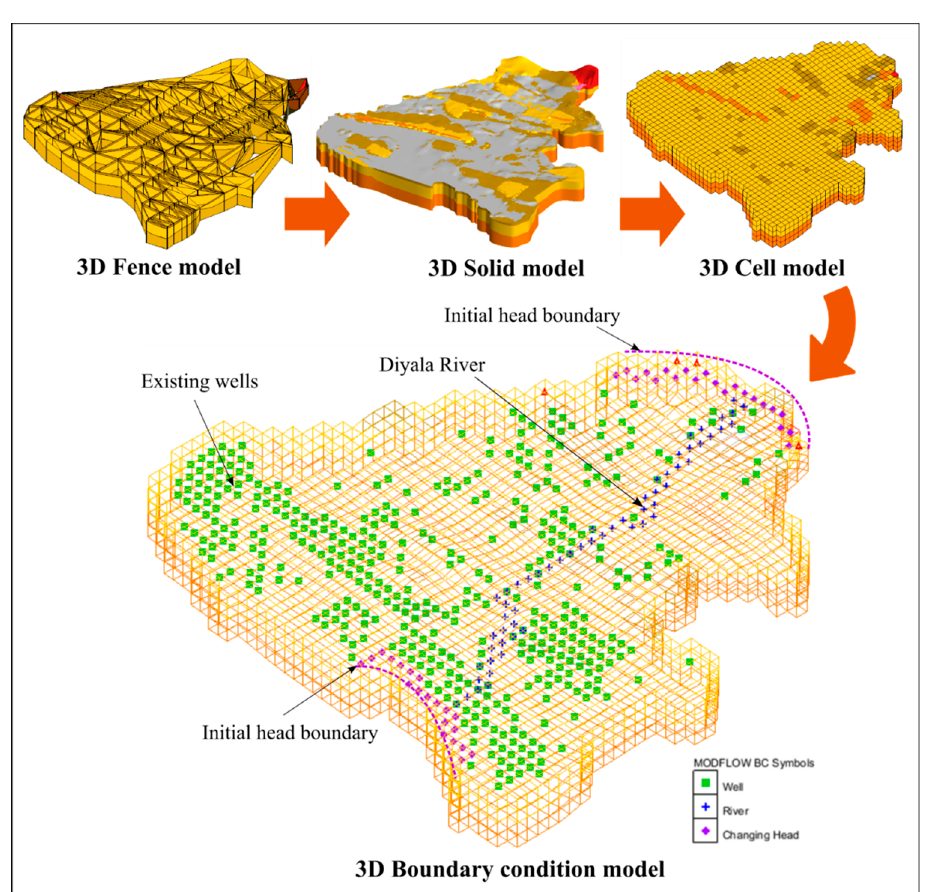
Figure 3. MODFLOW conceptual model development from 3D fence, 3D sold, 3D cell, and 3D boundary conditions models using groundwater modelling system (GMS) software.